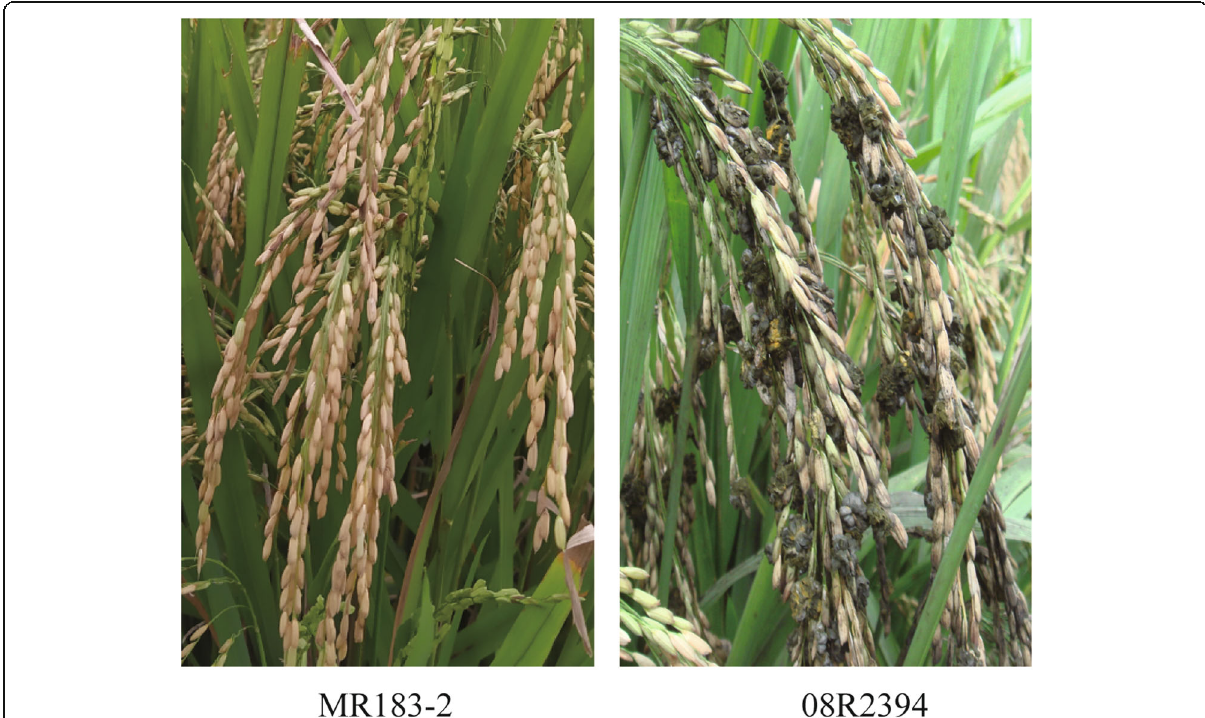
Fig. 1 False smut disease phenotypes of rice parental lines 08R2394 and MR183 – 2. Disease symptoms of false smut on rice panicles of the parental lines 08R2394 and MR183 – 2 after natural infection. Many false smut balls were formed on rice panicles of 08R2394, whereas only a few balls were formed on MR183 – 2 panicles. The photos were taken about 4 weeks after heading